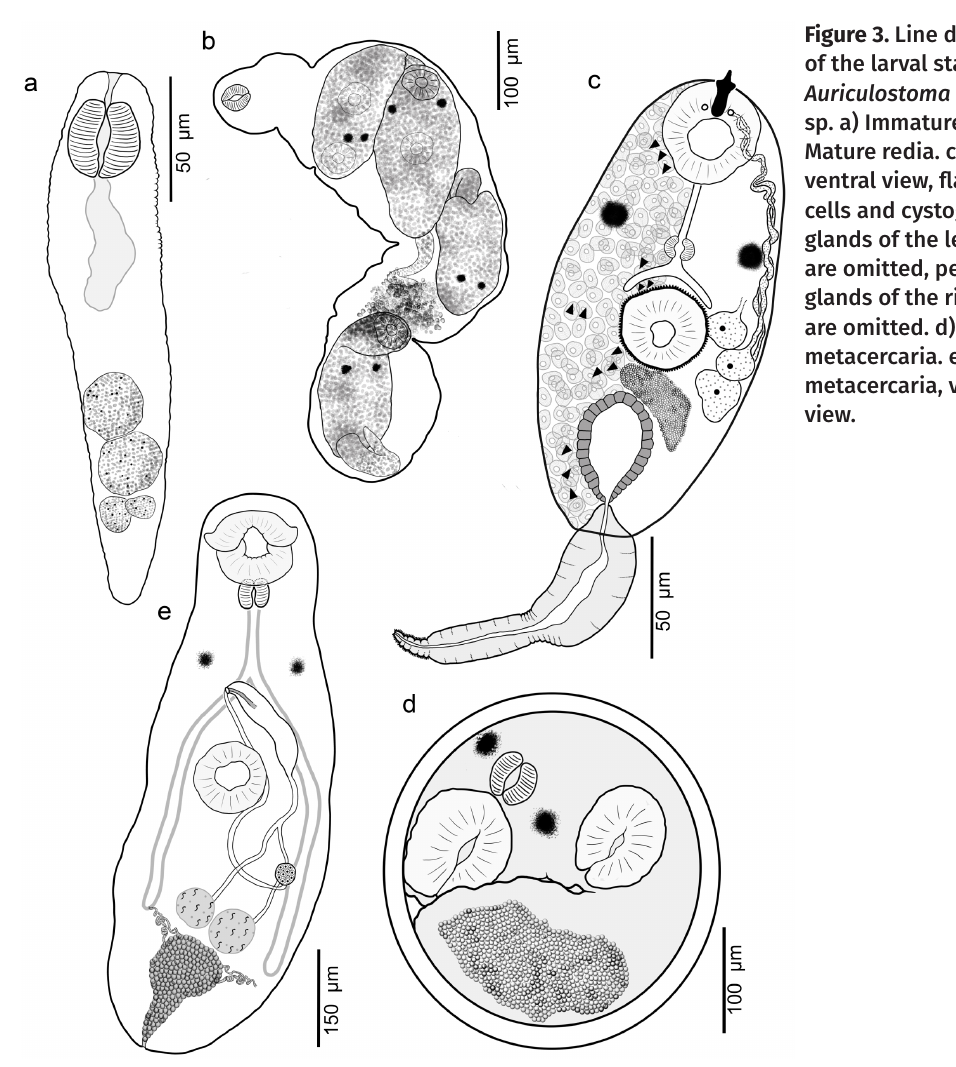
Figure 3. Line drawings of the larval stages of Auriculostoma ocloya